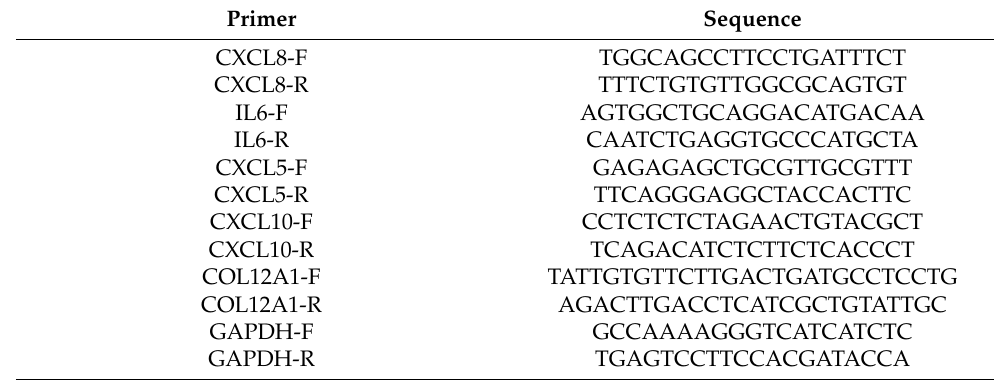
Table 1. The primer